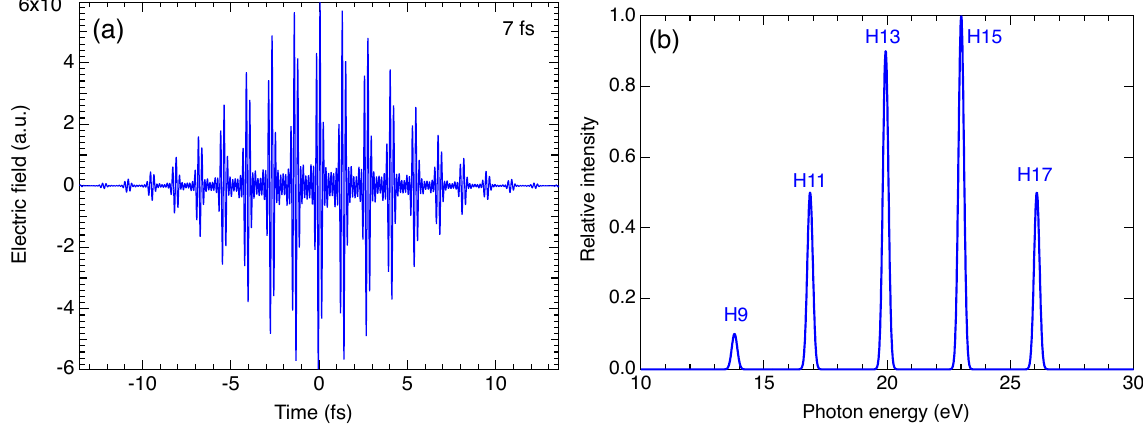
( a ) Pulse shape and ( b ) intensity spectrum of a 7 fs high-harmonic pulse (attosecond pulse train) composed of multiple harmonic orders used in the present study (see